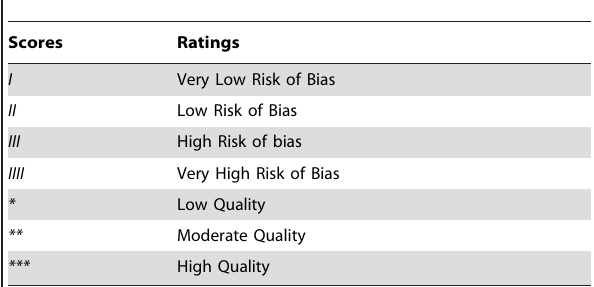
Table 3. Quality Assessment